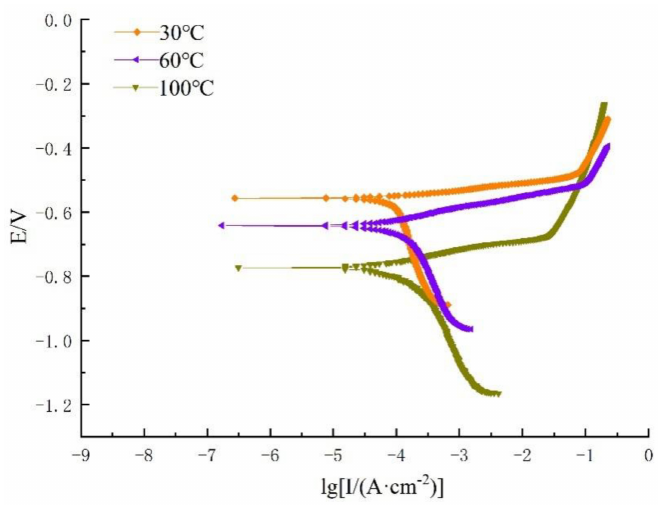
Figure 7. Polarization curve containing 0.3% Na 2 S.9H 2